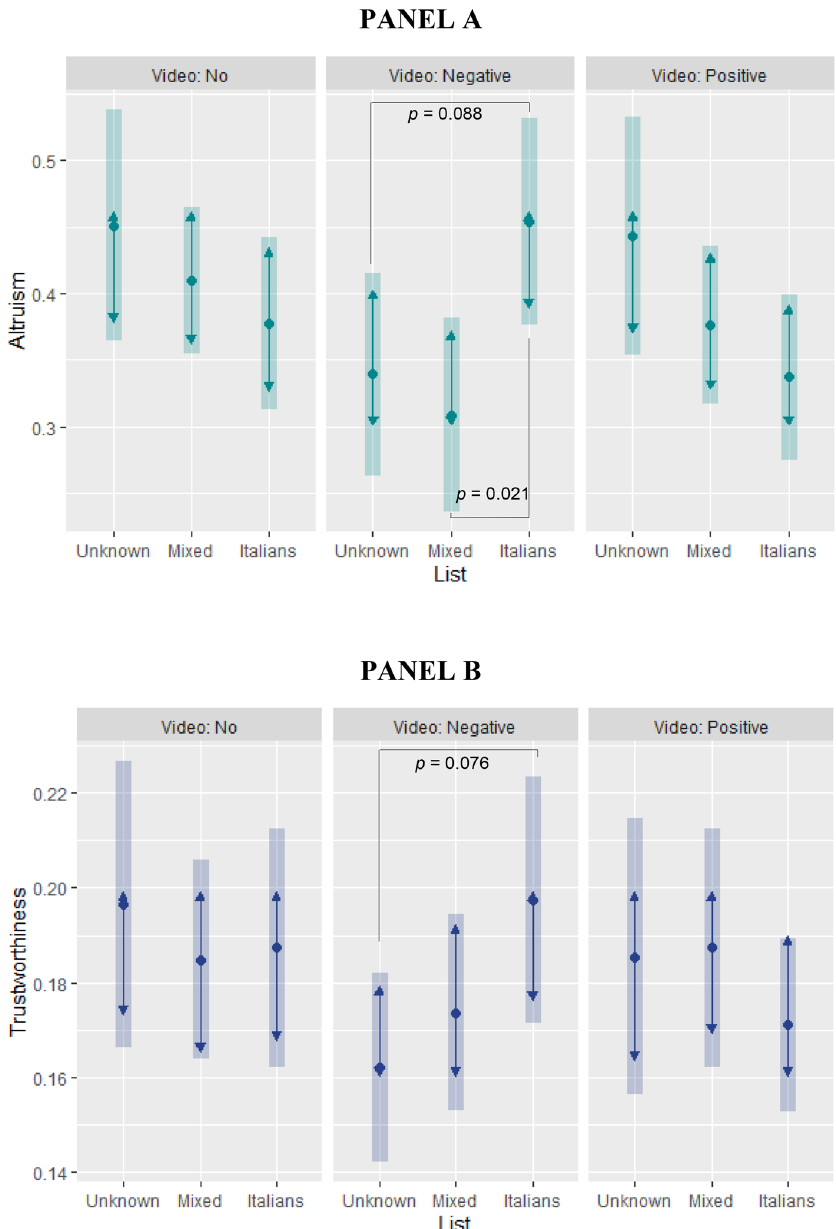
Figure 1. The effects of media portrayals of immigrants on prosociality (Study 1). Estimated marginal means (range 0–1) of altruism ( A ) and trustworthiness ( B ) by video and list conditions (Tukey adjustment for contrasts; bars: 95% confidence intervals; non-overlapping arrows: statistically significant pairwise comparison, p < 0.05). Altruism: money sent to the partner over initial endowment in dictator game; Trustworthiness: returned over received money in trust game, averaged across all hypothetical trustor’s transfers. Sample: Study 1